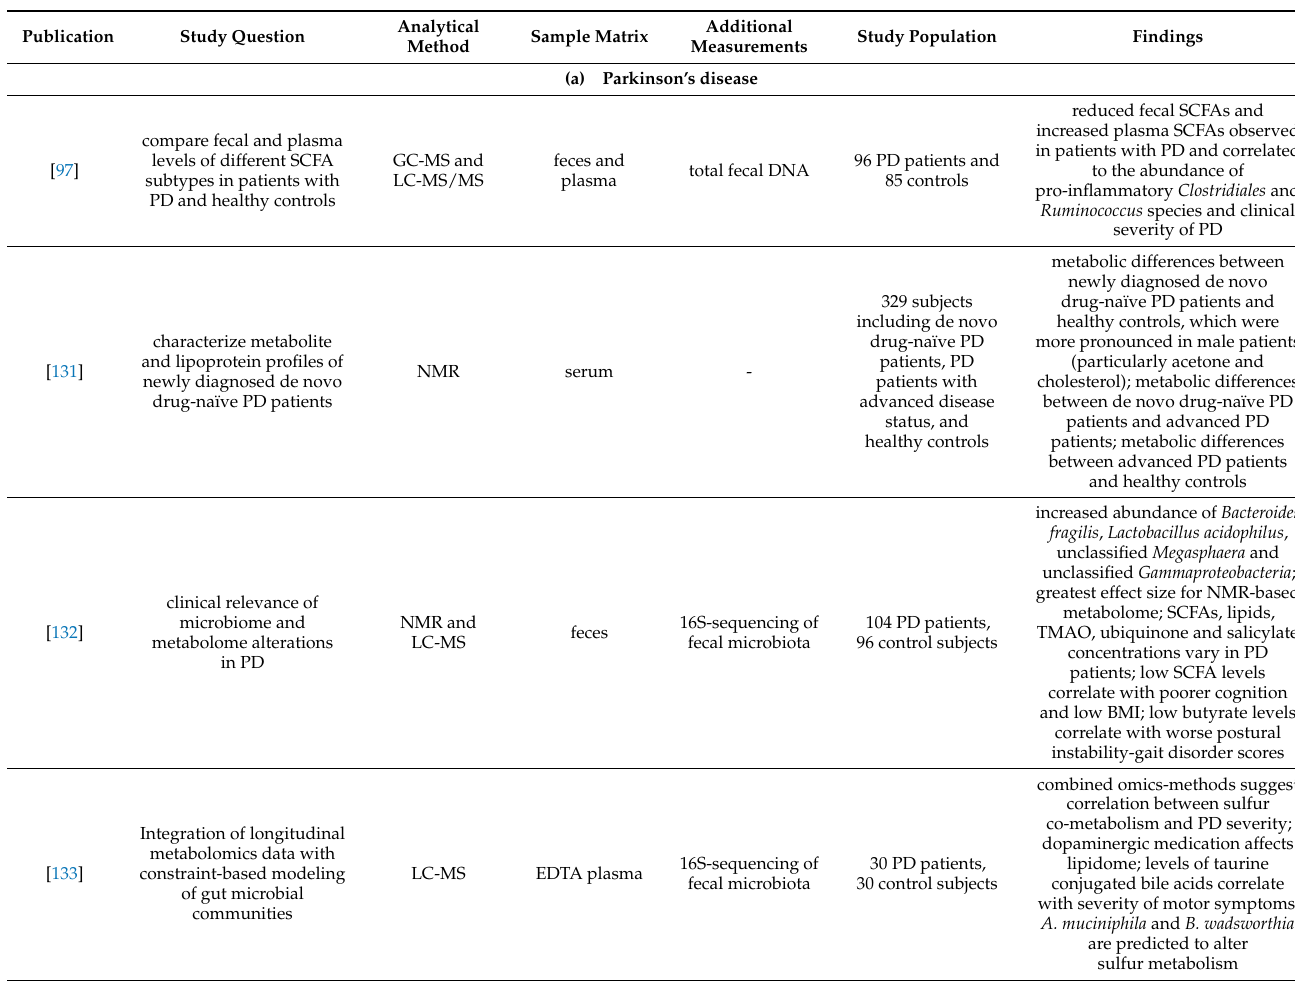
Table 1. Recent metabolomics studies in (a) Parkinson’s and (b) Alzheimer’s